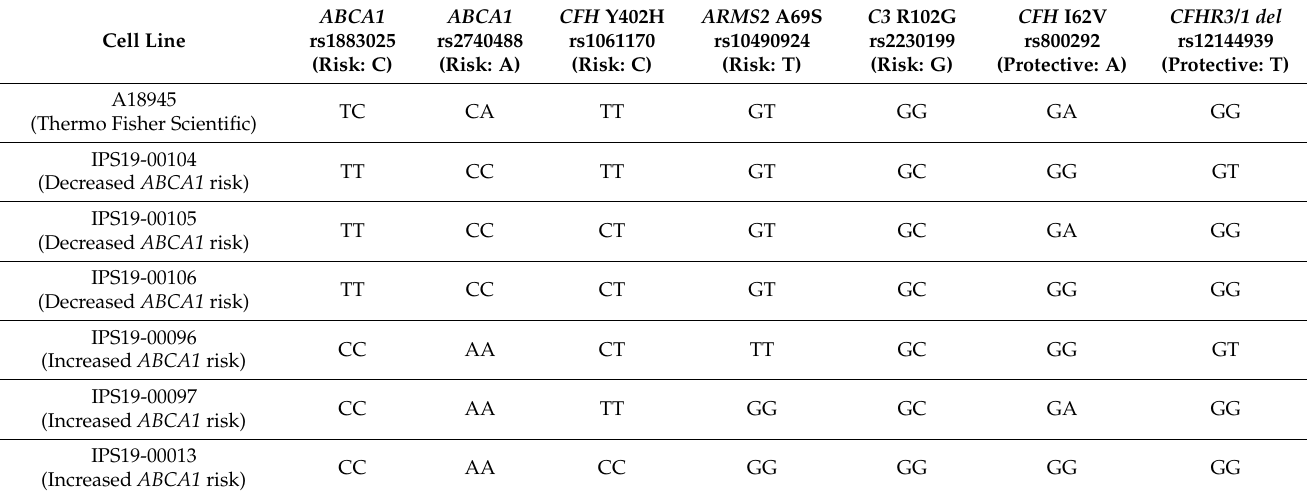
Figure 3. LXR agonist-stimulated ABCA1 expression and function in patient-derived iRPEs. Patient- derived iRPE lines were stimulated for 16 h with LXR agonist and are relative to unstimulated cells shown in Figure 2. ( A ) Expression of ABCA1 mRNA normalized to RPL28 and relative to un- stimulated cells shown in Figure 2B. ( B ) Western blot analysis of ABCA1 protein levels. Actin was detected as loading control. ABCA1 expression was quantified and normalized to actin. ( C ) Cholesterol efflux assay after direct cell labeling and in the presence of ApoAI. ( D ) Choles- terol efflux assay after phagocytosis of BODIPY-cholesterol-loaded POSs and in the presence of ApoAI. Data are relative to unstimulated cells shown in Figure 2F,G, respectively. Data are presented as means ± SD (n = 3). Unpaired Student’s t -test. * p < 0.05. Table 1. Genotypes of AMD-associated polymorphisms in all used iPSC